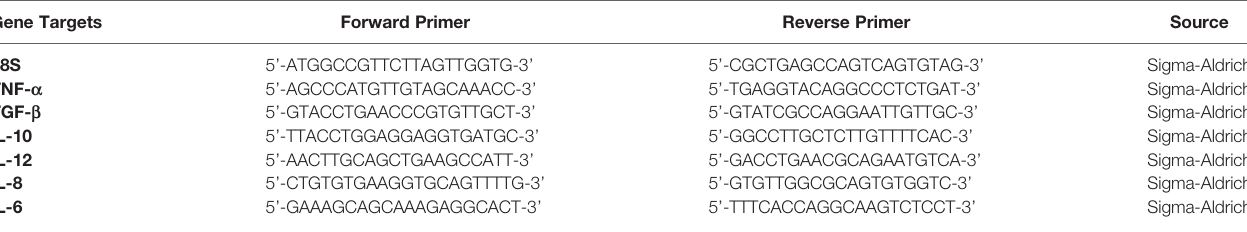
TABLE 2 | Primers sequences used for real-time quantitative polymerase chain reaction (qPCR). Gene